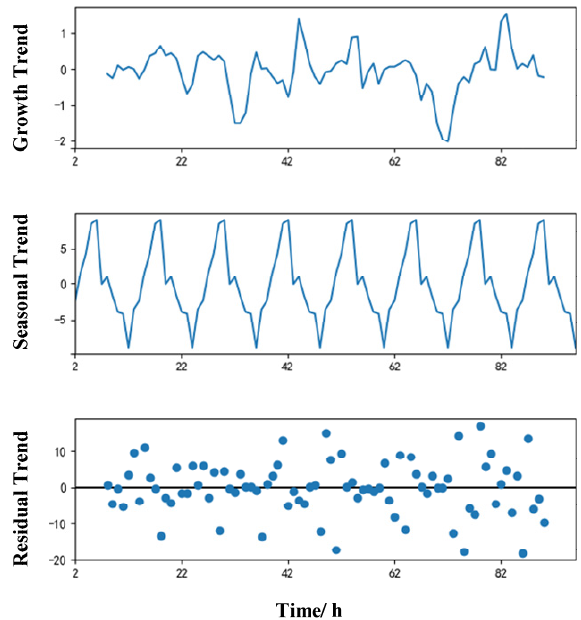
Figure 14. Analysis of offset azimuth trend.